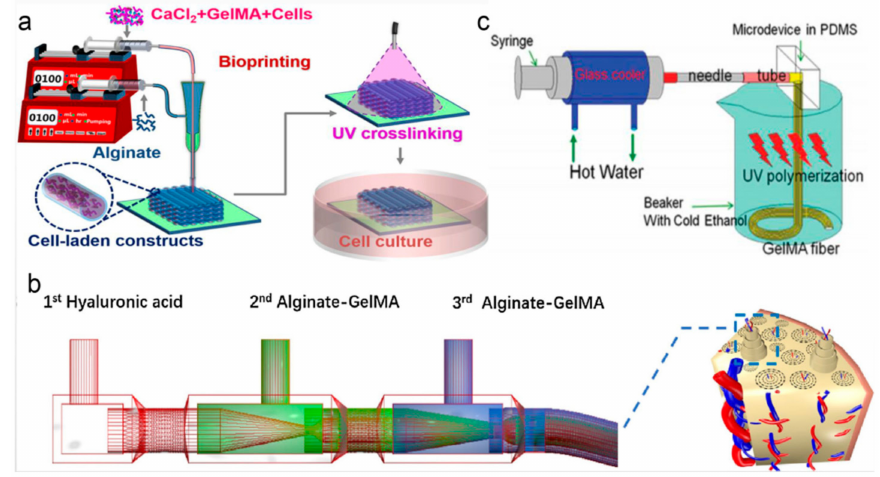
Figure 1. ( a ) Extrusion method: strategy of bioprinting GelMA / alginate core / sheath microfibers into 3-D constructs with tunable microenvironments. Reproduced with permission [57]. ( b ) Laminar flow-based method: Capillary microfluidic device used for biomimetically constructing osteon-like double-layer hollow microfiber with the novel composite bioink. Reproduced with permission [59]. ( c ) Electrospinning method: The microdevice to generate microstructured GelMA fibers. Reproduced with permission